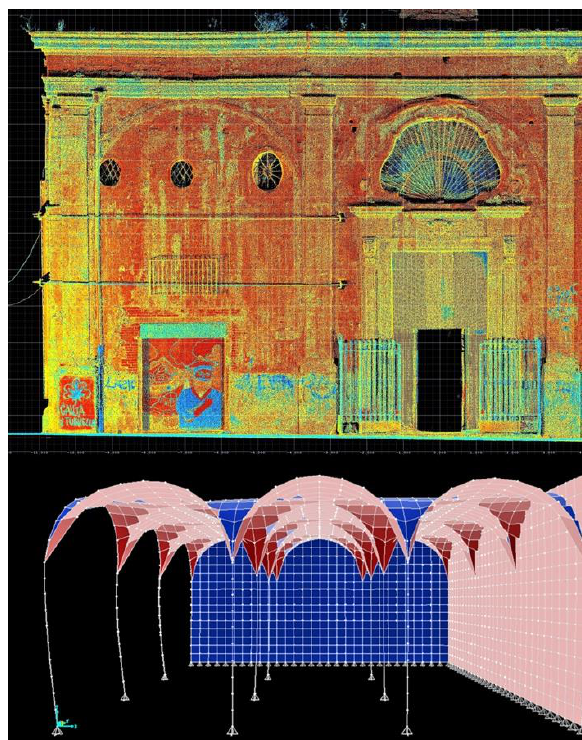
Figure 7. The point cloud of the façade and the structural behavior model.